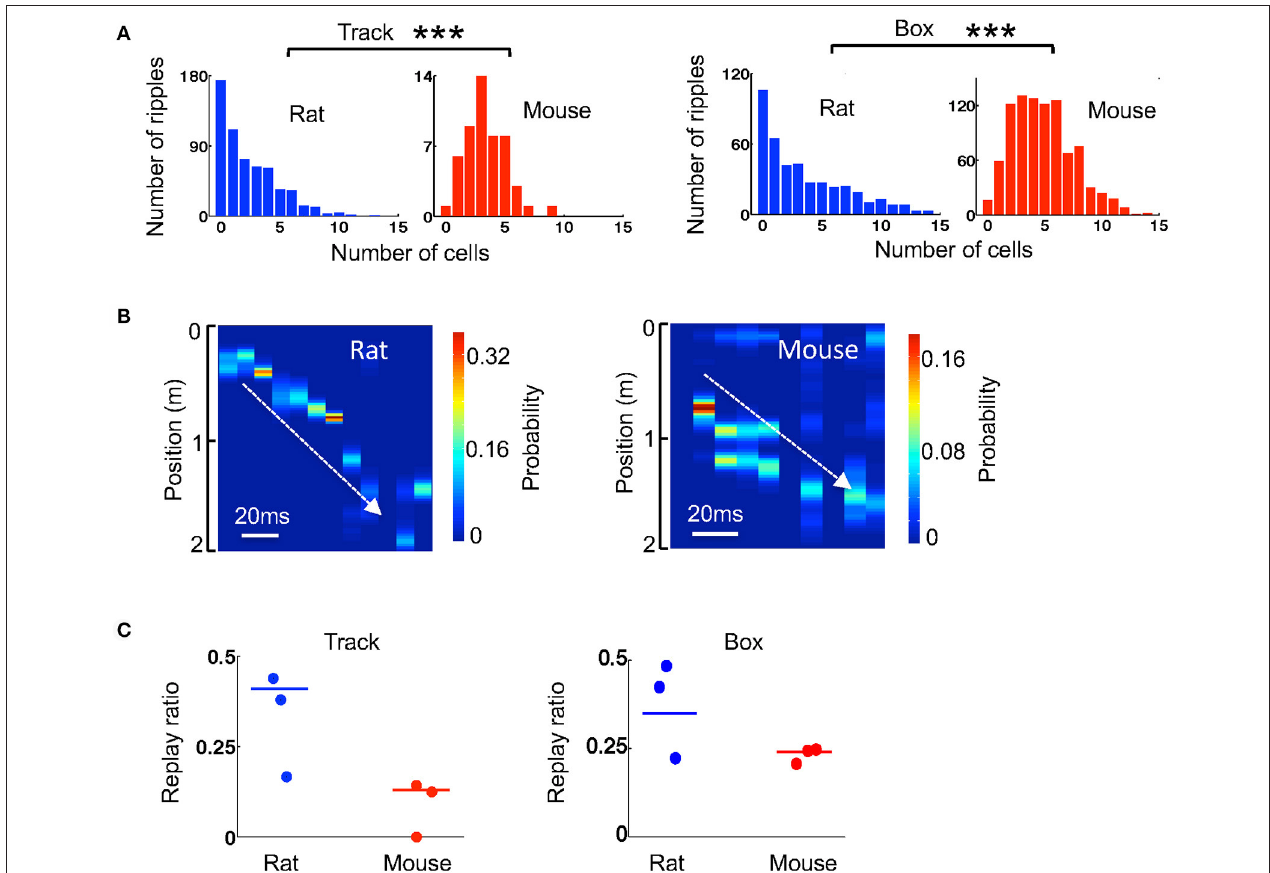
FIGURE 6 | Ripple-associated replay was relatively weaker in mice than that in rats. (A) Histograms of rat and mouse ripples with different number of active template cells during stopping on the track and during resting in the box. *** P < 0.001. (B) An example replay event in a rat and one in a mouse identified by Bayesian decoding. Color represents the decoded probability of each position at each time point (10ms) of a ripple. The decoding was based on the two templates in Figure 4A . Note that the decoded peak locations replayed a part of a trajectory on the track (white line) in both examples. (C) Replay ratio of the number of replay events over all candidate ripples during stopping on the track and during resting in a box for every animal. Each dot indicates an animal. Solid lines: group replay ratios (number of all replay events over all candidate ripples combined from all animals of a